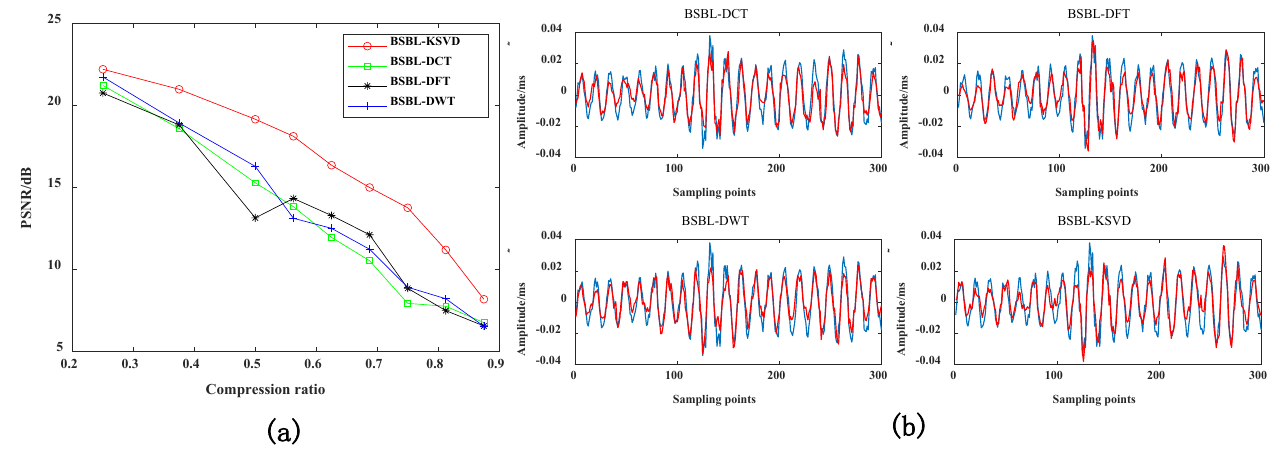
Figure 9. ( a ) Comparison of PSNR indicators for different sparse dictionaries; ( b ) when CR = 0.7, the reconstruction signal comparison of different dictionaries.